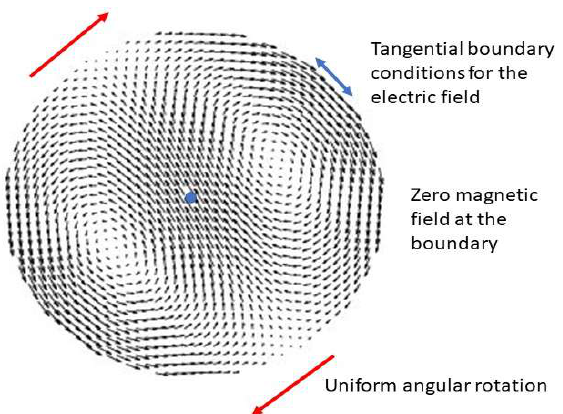
Figure 1. Electric field displacement inside the section of the cylinder at a prescribed time. The image rotates clockwise with constant angular speed. This particular solution of Maxwell’s equations was constructed with the help of Bessel’s functions. The radial component is zero at the boundary, so the field is tangent to the cylinder there. The magnetic field is orthogonal to the page and is also zero at the